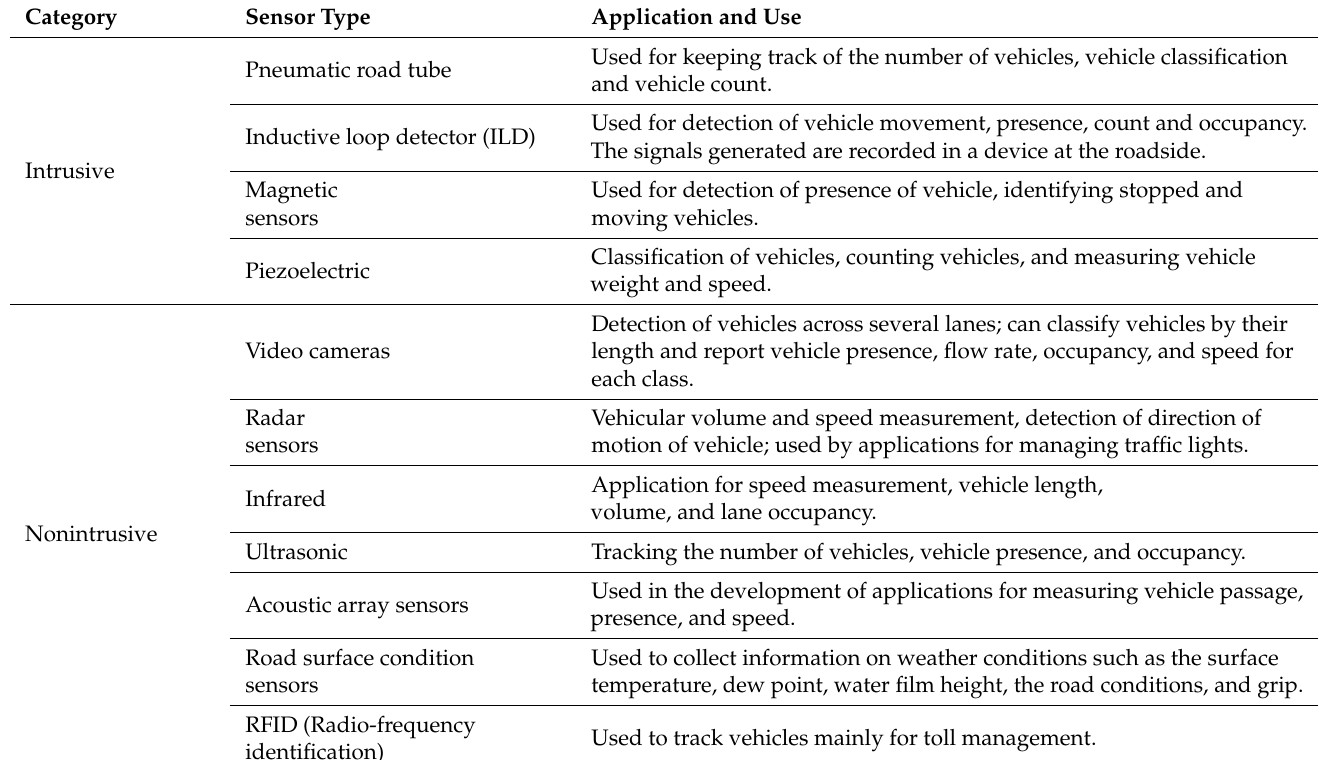
Table 1. Sensors used for traffic control (from